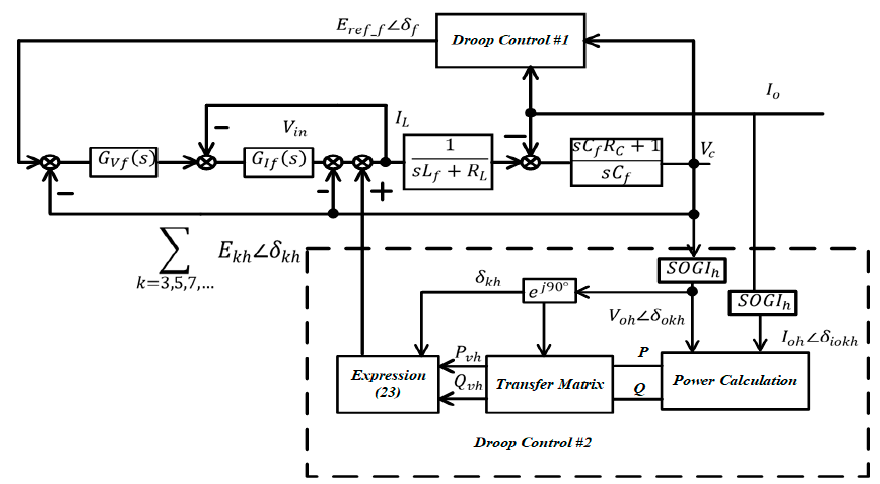
Figure 7. The control block diagram of the voltage harmonic mitigation.